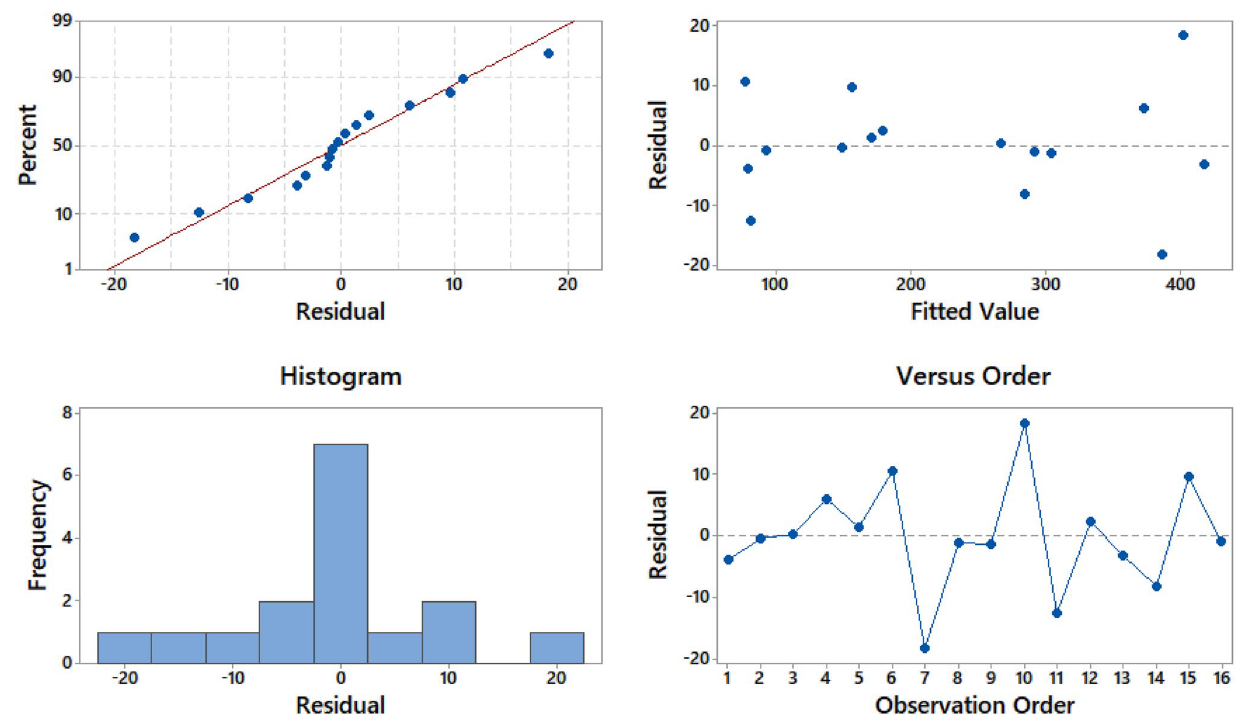
Fig. 22 Residual plot of the cutting force F x for SiCp/Al